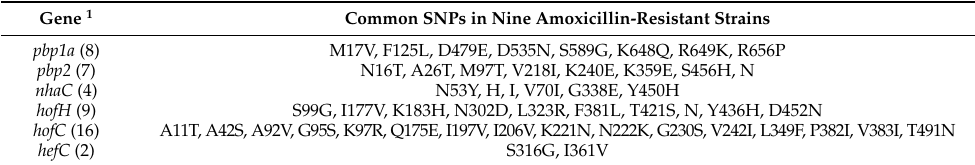
Figure 2. Distribution of clarithromycin resistance rates among clinical Helicobacter pylori strains. Table 2. WGS analysis results of amoxicillin-resistant Helicobacter pylori